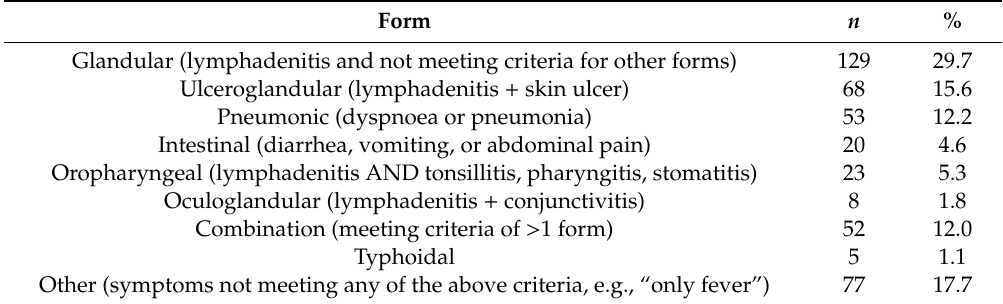
Table 1. Notified tularemia cases with laboratory confirmation by clinical presentation, Germany, 2002–2019 ( n = 435) [ n = total number of tularemia cases]. Form n % Glandular (lymphadenitis and not meeting criteria for other forms) Ulceroglandular (lymphadenitis + skin ulcer)